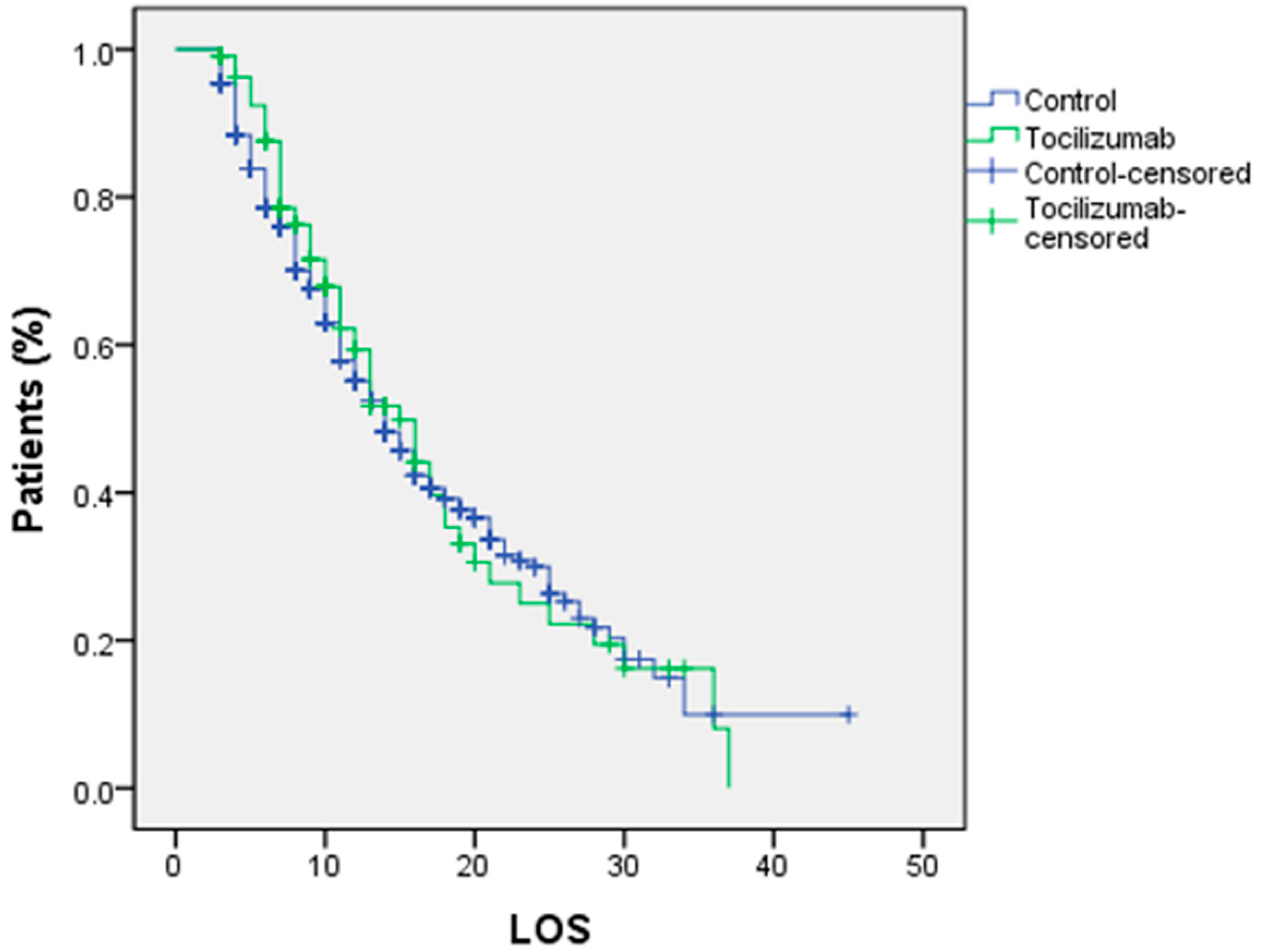
Figure 1. Kaplan–Meier curve of the survival rate among patients of the study groups (log rank test p < 0.669). Table 6. Distribution of respiratory support at the time of hospitalization regarding the primary outcome.